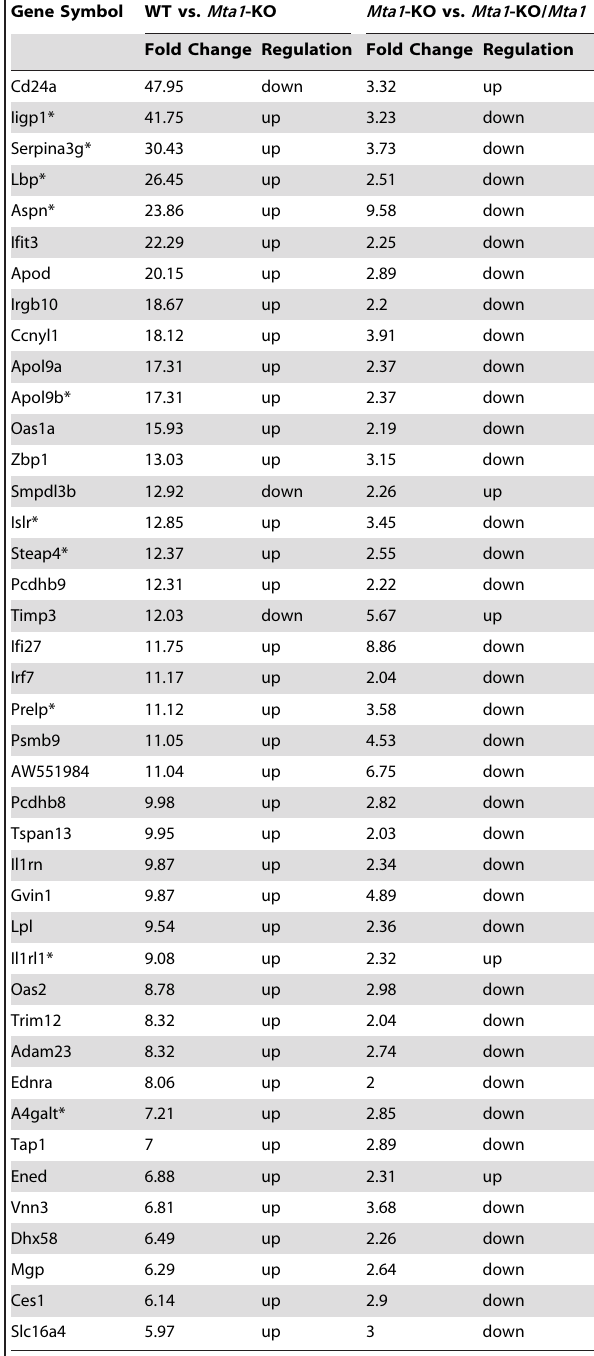
*Genes (32) regulated by Mta1 irrespective of P53 status. Figure 3A (lower